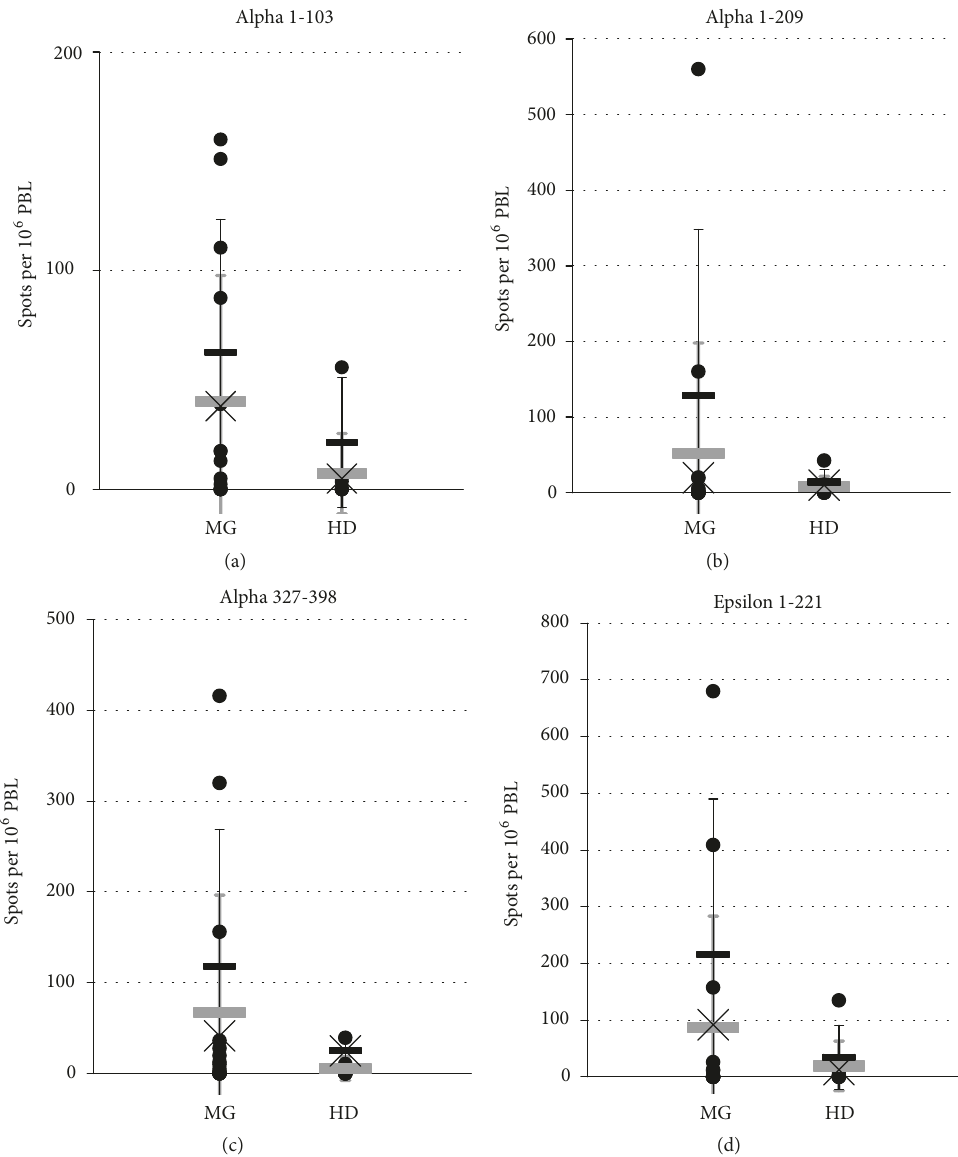
Figure 1: Frequency of IFN- 𝛾 -secreting events per 10 6 PBL in single donors. ELISPOT assay was performed as described in the text. Results are assigned as the numbers of IFN- 𝛾 -secreting events among 10 6 PBL minus the corresponding numbers of events per 10 6 PBL without antigen. Negative results (spot number without antigen exceeding spot number with antigen) were defined zero. Grey bars, mean response ± SD; black bars, mean positive response ± SD; crosses, median positive response; MG, myasthenia gravis patients; HD, healthy donors. Note the high standard deviations due to heterogeneous responses of single individuals (see Table 1). Note the different Y axis scales using four different recombinant fragments. (a) fragment Alpha 1-103; (b) Alpha 1-209; (c) Alpha 327-398; (d) Epsilon